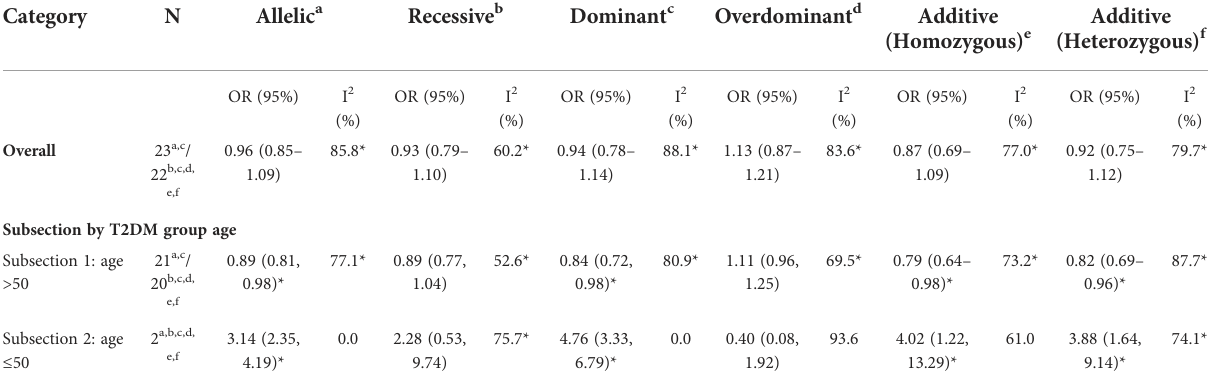
TABLE 3 Meta-analyses of the resistin (RETN) -420C/G gene polymorphism and the risk of type 2 diabetes mellitus (T2DM) in subgroups strati fi ed by the patients ’ mean age. Category N